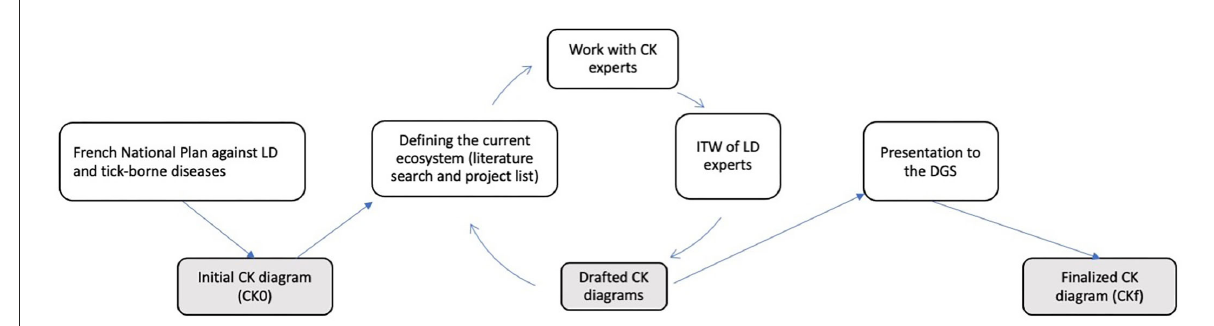
FIGURE1 Methodological approach to build the concept-knowledge (CK) diagram to identify innovative research that would be developed to fight Lyme disease in France. LD, Lyme disease; C, concept; K, knowledge; ITW, interviews; DGS, Direction Générale de la Santé (Health General Division of the French Ministry of